Question: Looking at the figure, what chart type is it?
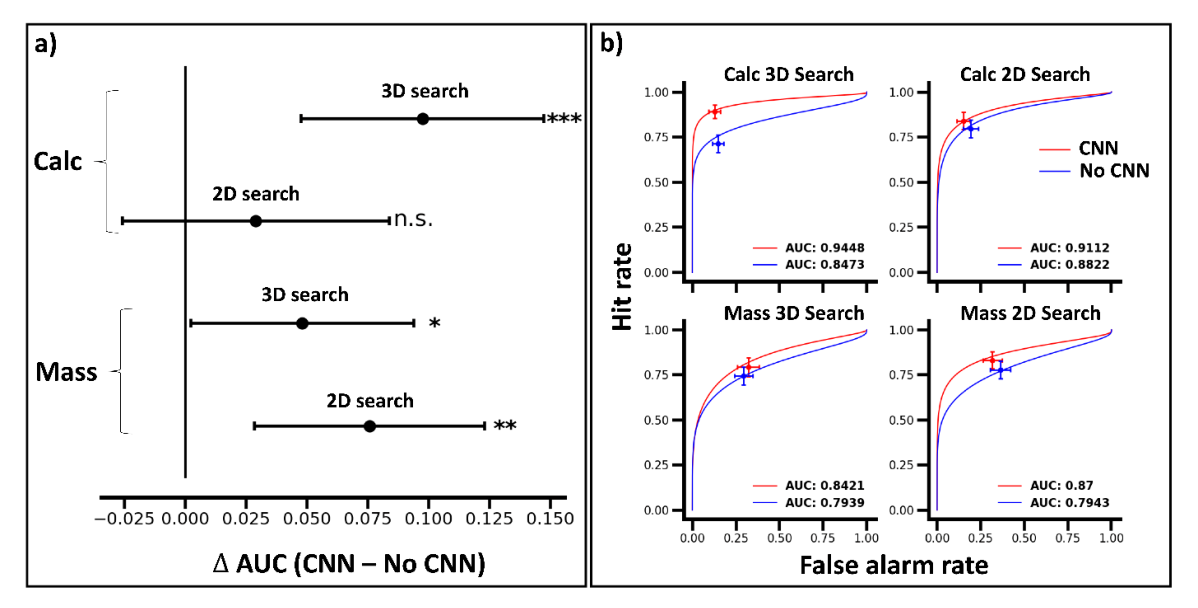
Answer: scatter